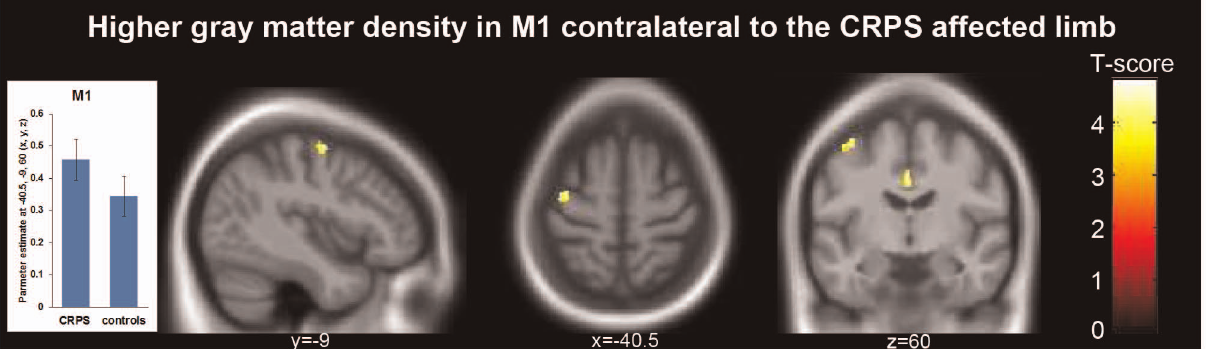
Figure 2. To identify structural changes in the somatosensory cortex, MRI scans of patients with left-sided CRPS were horizontally flipped before data pre-processing and statistical comparison (i.e., CRPS . controls). Using small volume correction we found one significant cluster with increased gray matter density, which was located in the primary motor cortex (M1: peak voxel-level: –40.5, –9, 60 (x, y, z, mm), T=4.31, p , 0.001 uncorrected, cluster-level: 89 voxels, p=0.042 FWE corrected). As for the DMPFC (see Fig. 1), we found no correlation between altered grey matter density in primary motor cortex and clinical CRPS features (see Results). The bar plot shows estimated gray matter density of the peak voxel and whiskers indicate standard